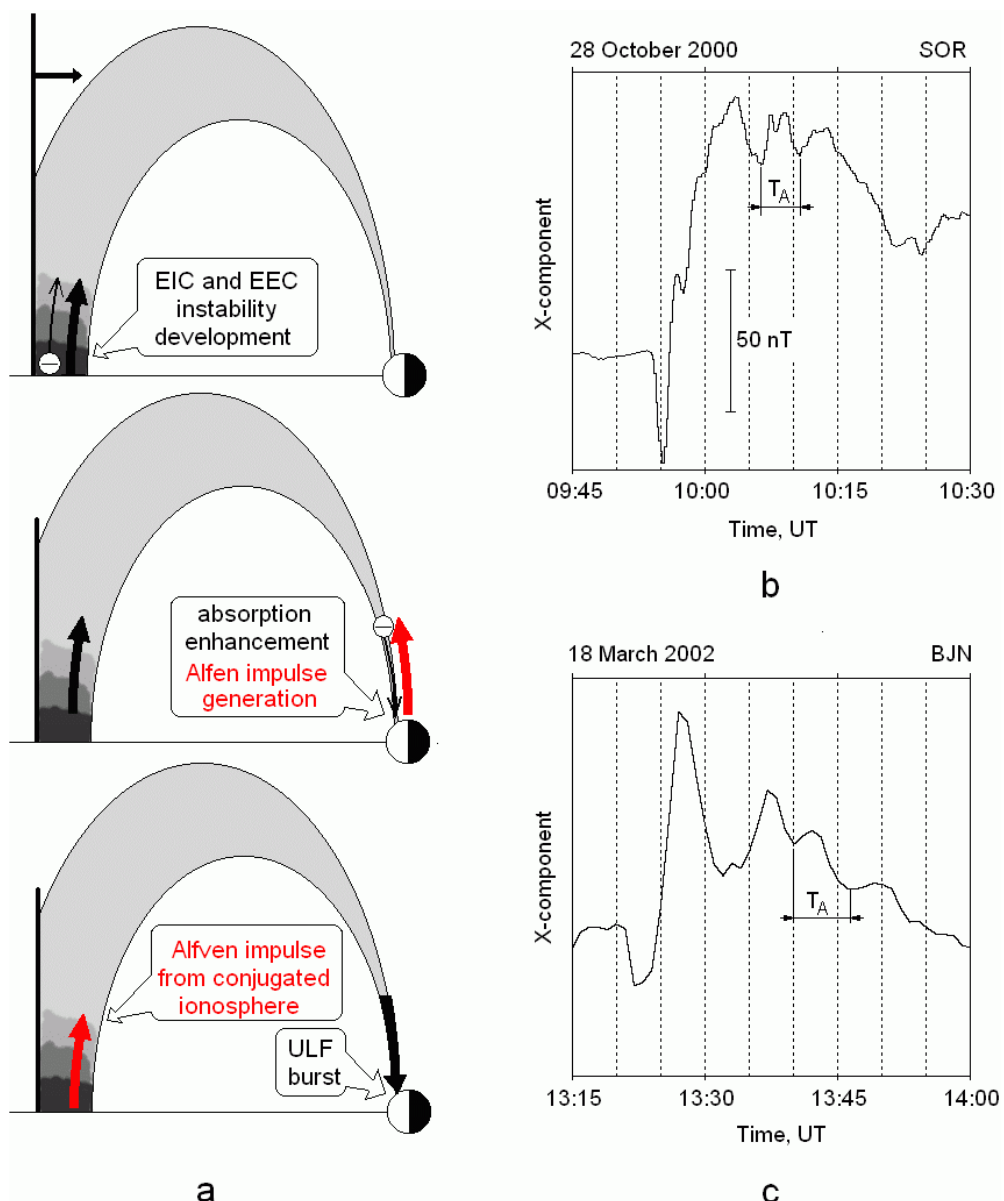
Fig. 14. (a) Sketch showing the reason of the lag of rising burst relatively SCA and generation and propagation of the Alfv´en impulses (red arrows); (b, c) magnetic pulsations at observatories located just below the ionospheric irregularity. Period of pulsations, T A , corresponds to the propagation time of the Alfv´en impulse between conjugated